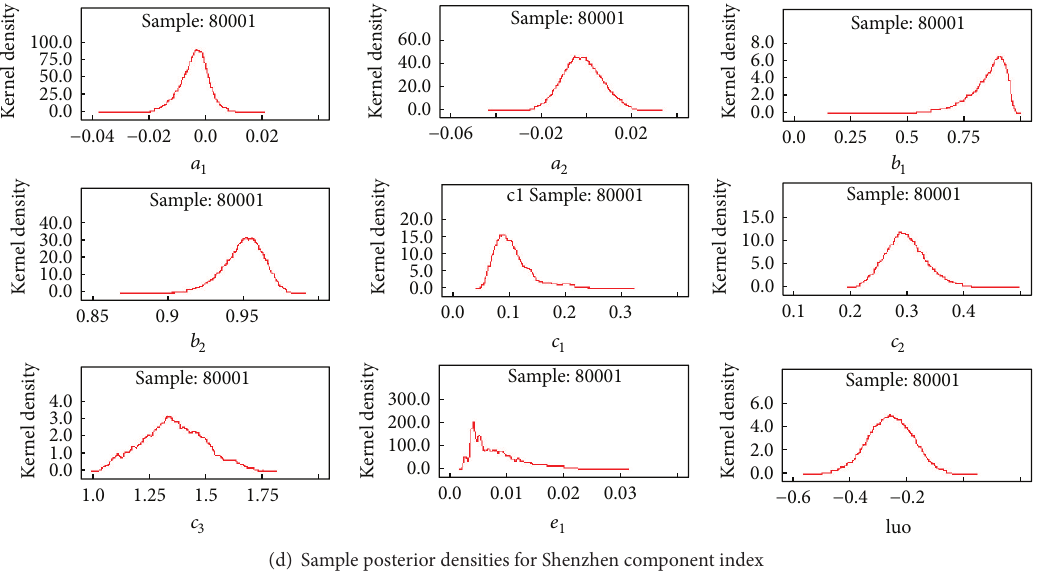
(d) Sample posterior densities for Shenzhen component index Figure 5: Sample path and density estimates for two indices.